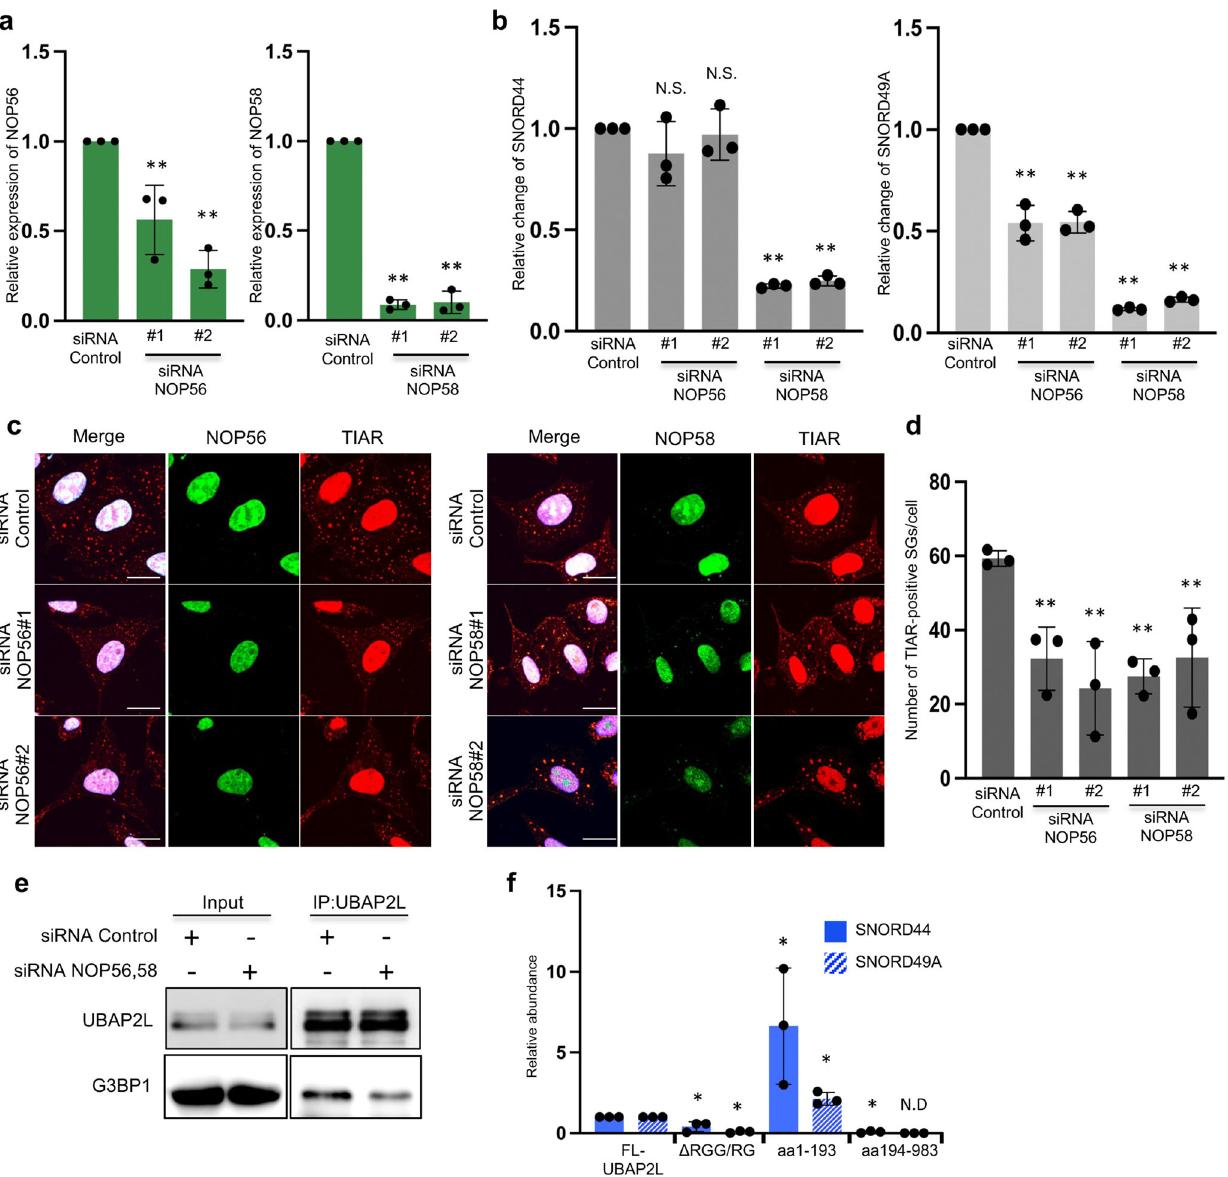
Fig. 6 C/D box snoRNAs regulate SG assembly. a HeLa cells were transfected with control, NOP56 or NOP58 siRNAs. After 72 h, the expression of NOP56 (left graph) or NOP58 (right graph) mRNA was examined by qRT-PCR. Three independent experiments were performed (** P < 0.01). b The abundance of SNORD44 (left graph) or SNORD 49 A (right graph) was examined by qRT-PCR ( n = 3, ** P < 0.01, N.S. (not signi fi cant) P > 0.05). c HeLa cells were transfected with control, NOP56, or NOP58 siRNAs, and 72 h later, the cells were treated with 0.5 mM aresenite for 30 min and immuostained with anti-TIAR together with anti-NOP56 or anit-NOP58 antibodies (scale bar = 10 μ m). d The number of SGs per cell is presented in the graph. Three independent experiments were performed ( n = 20, ** P < 0.01). e HeLa cells were transfected with control siRNA or a combination of NOP56 #1 and NOP58 #1 siRNAs, and 72 h later, the cells were lysed and immunoprecipitated with anti-UBAP2L antibody. The immunoprecipitates were subjected to immunoblot analysis. f Small RNAs were isolated from immunoprecipitates from the lysate of 293T cells that constitutively expressed the FLAG-UBAP2L, FLAG-1-193, FLAG- Δ RGG/RG(130-193), or FLAG-194-983. The levels of SNORD44 and SNORD49A were examined by qRT-PCR) ( n = 3, * P < 0.05, N.D. (not